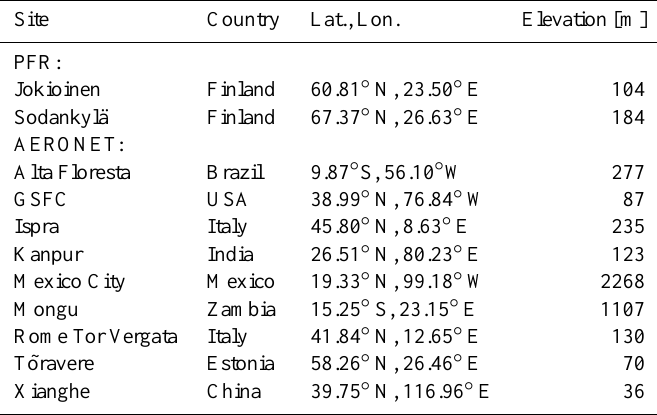
Table 1. Sunphotometer sites used in the study. PFR sites were in Finland and AERONET data was used elsewhere.